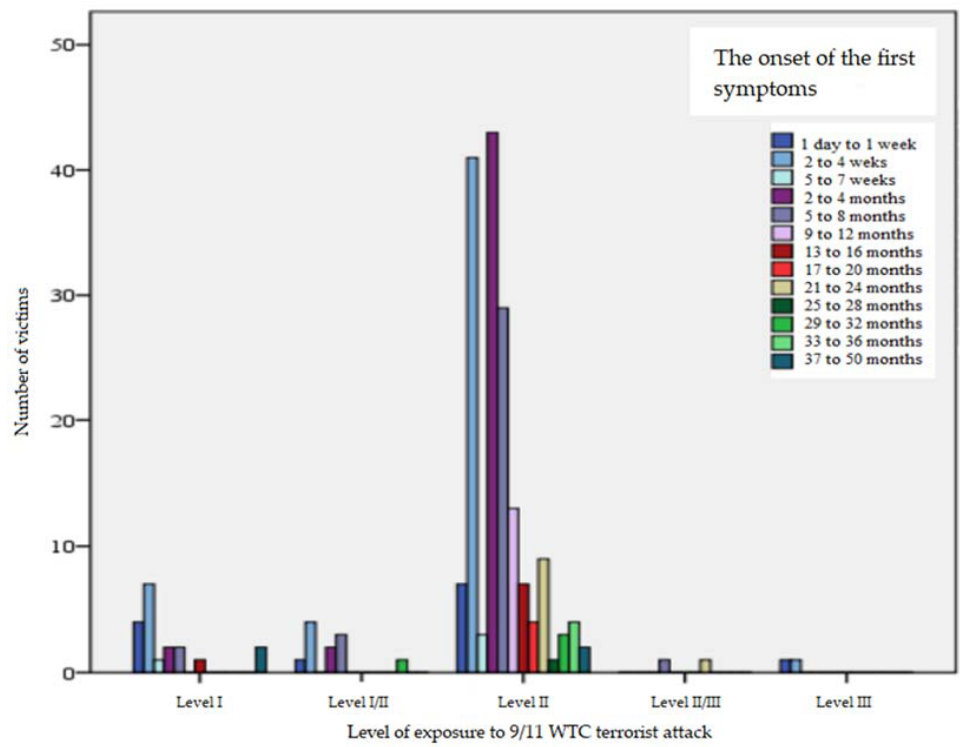
Figure 2. The distribution between the time of initiation of contact with the stressor and the onset of the first symptoms of victims. the first symptoms of